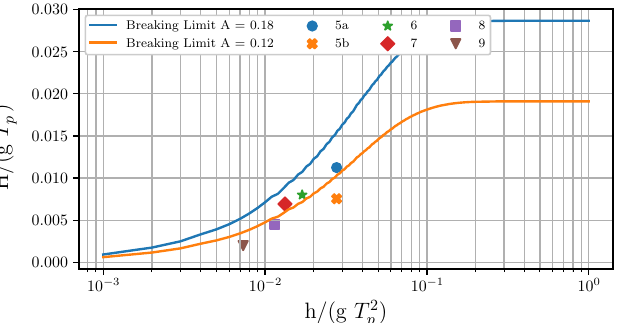
t f = 2 s . The focal position is −